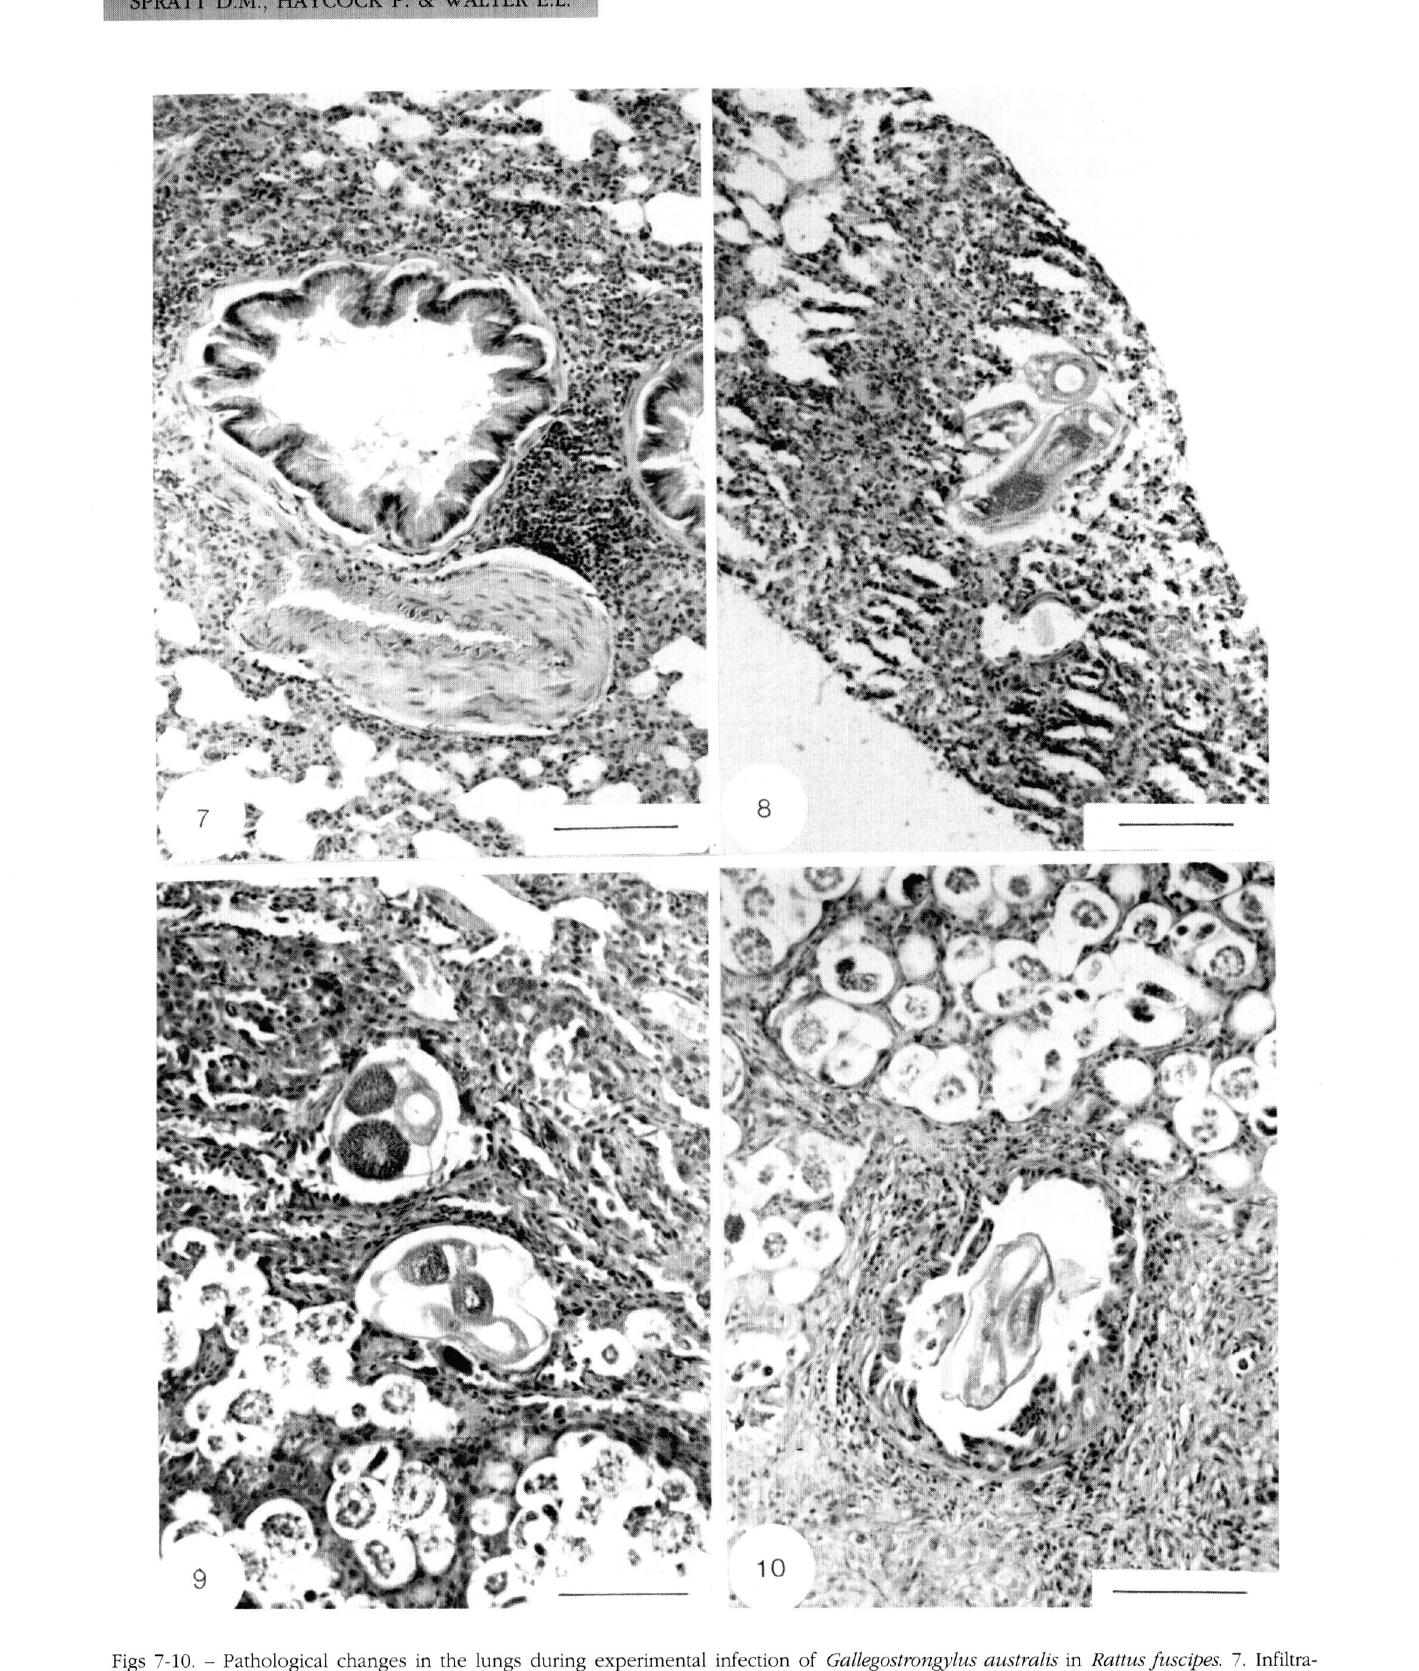
Parasite, 2001, 8,